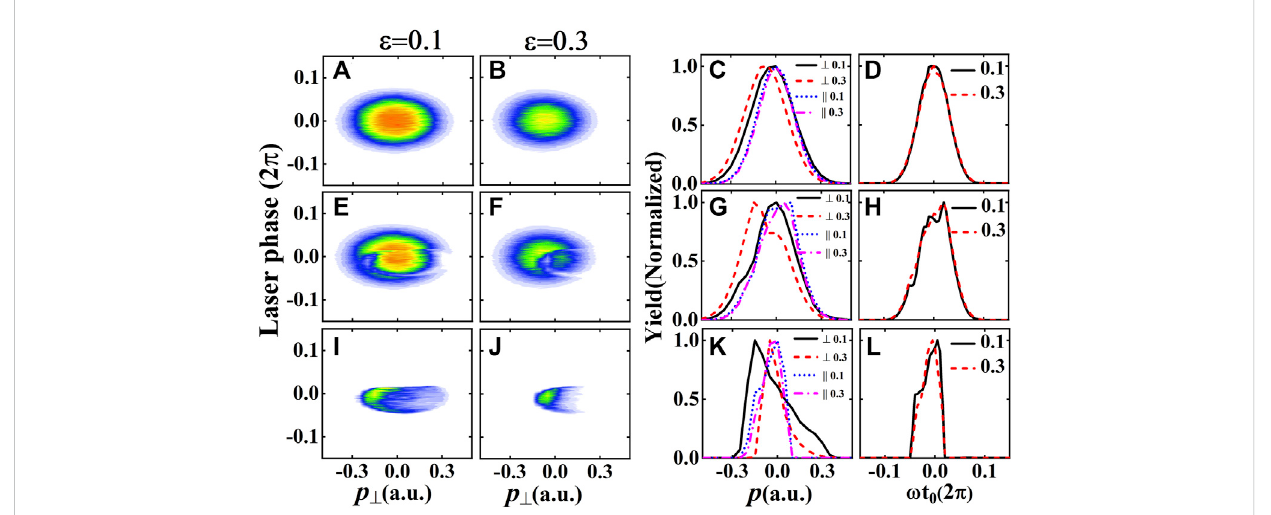
FIGURE 4 The laser phase dependence of the initial photoelectron transverse momentum distributions for tunneling (A, B) , ionization (E, F) and RSE (I, J) processes at the ellipticities of ε =0.1 (A, E, I) , ε =0.3 (B, F, J) . The initial photoelectron transverse momentum distributions in (C, G, K) and laser phase distributions in (D, H, L) are extracted from the data of (A, B) , (E, F) , and (I, J) , respectively. The initial photoelectron longitudinal momentum distributions for tunneling (C) , ionization (G) and RSE (K) are also presented. These data are calculated by the nonadiabatic model with the laser intensity of 4×10 13 W/cm 2 and the wavelength of 800